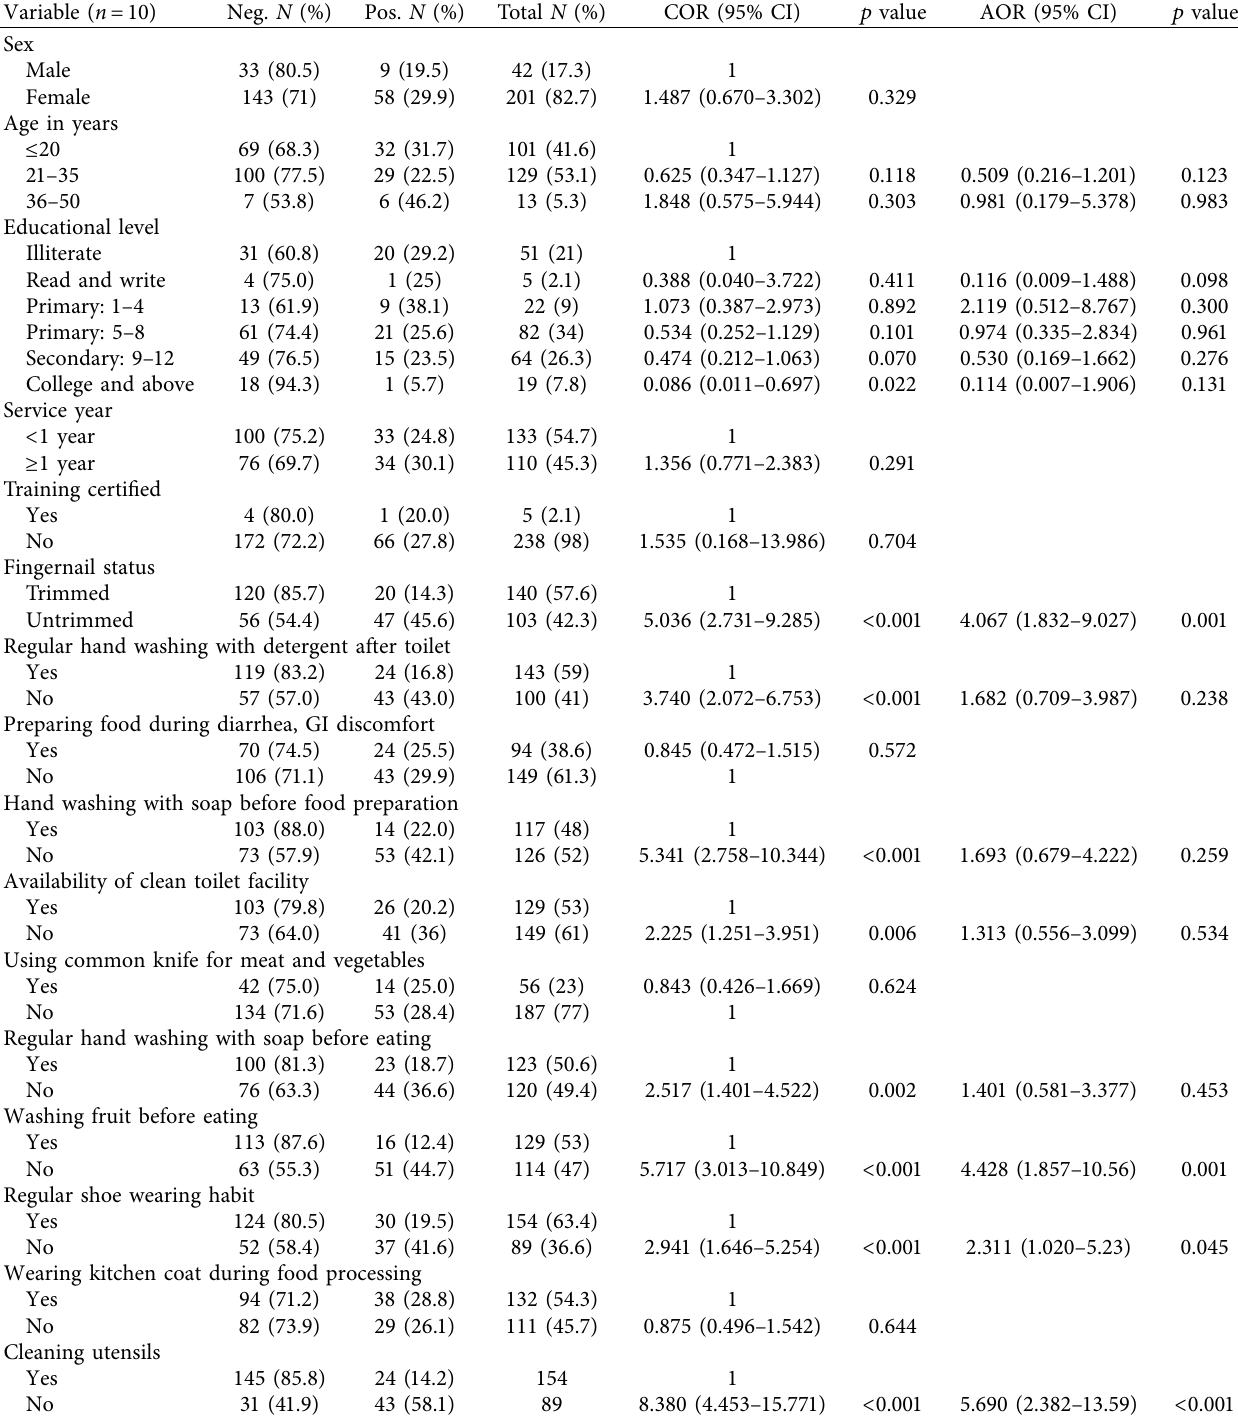
Table 1: Bivariate and multivariate analyses of risk factors associated with intestinal parasites in food handlers in Motta town, North West